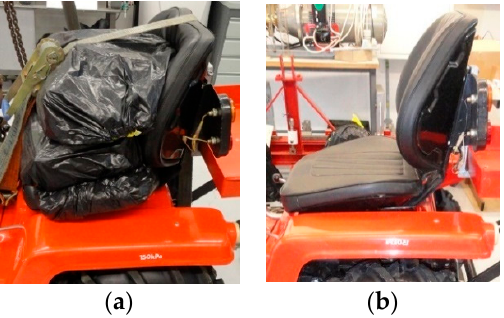
Figure 1. Tractor driver seat: ( a ) three sandbags to simulate the human body, ( b ) empty seat.